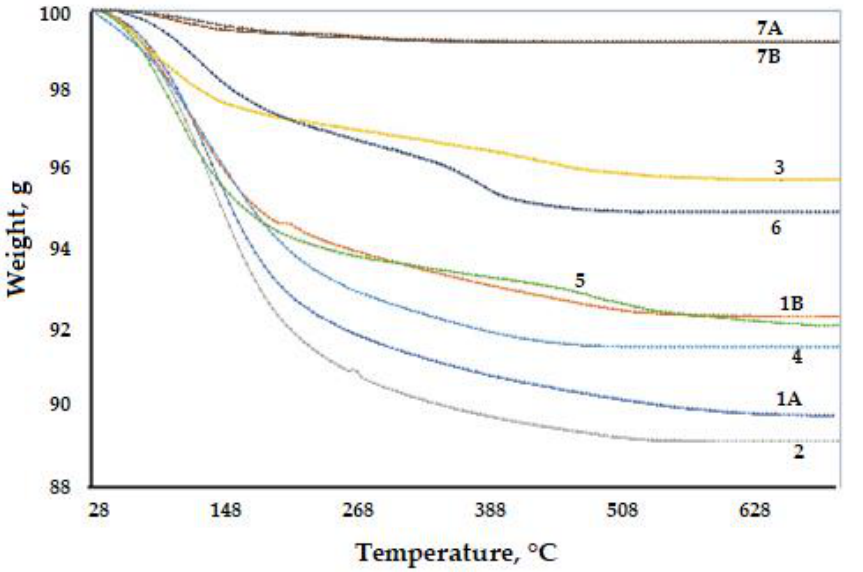
Figure 7. Thermogravimetric analysis of the investigated samples.